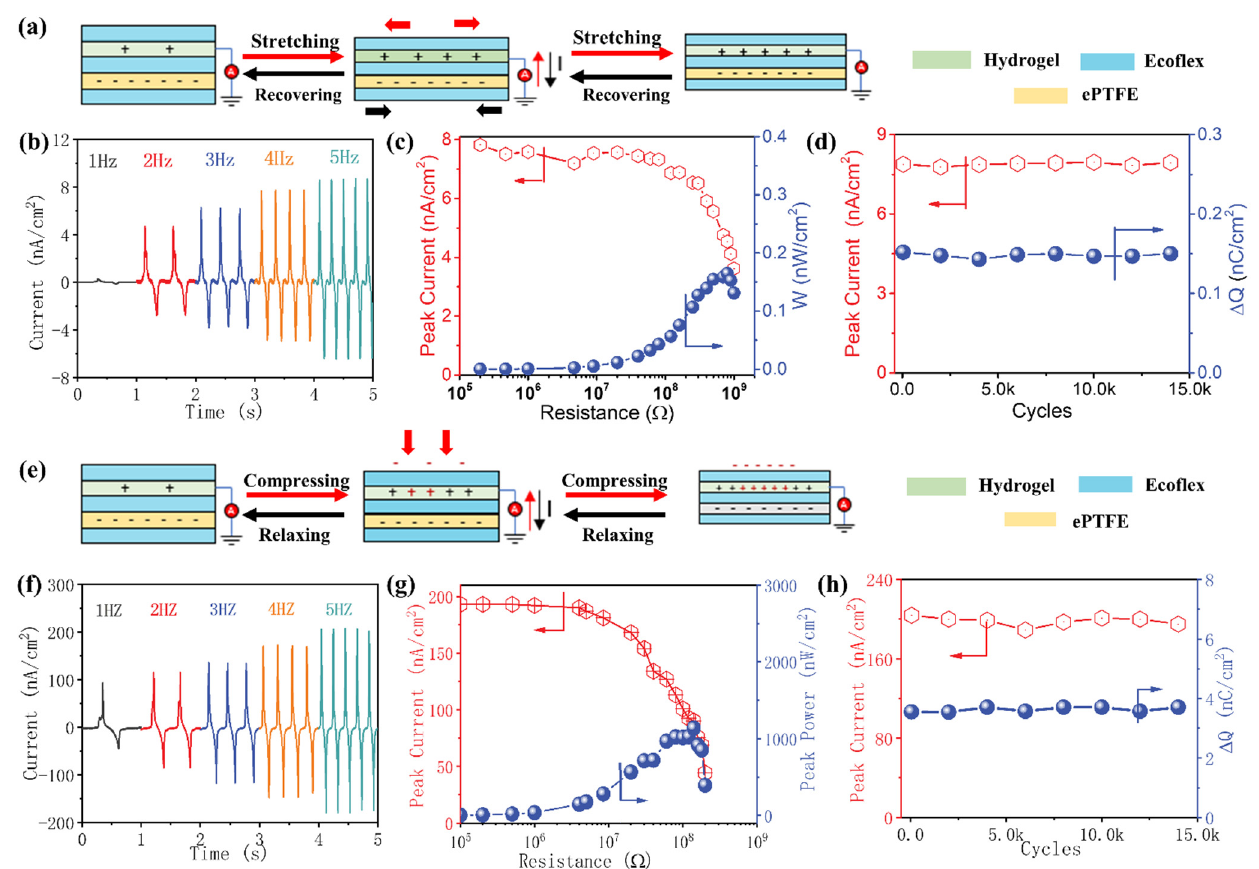
Figure 2. Working mechanisms and output characteristics of the self-powered flexible sensor in the strain ( a – d ) and pressure mode ( e – h ). ( a , e ) Working mechanisms of this self-powered flexible sensor. ( b , f ) Time-dependent variation of output current at different vibration frequencies. ( c , g ) Output peak current and output power as a function of resistance of external load resistor. ( d , h ) Durability tests of the as-fabricated sensor.